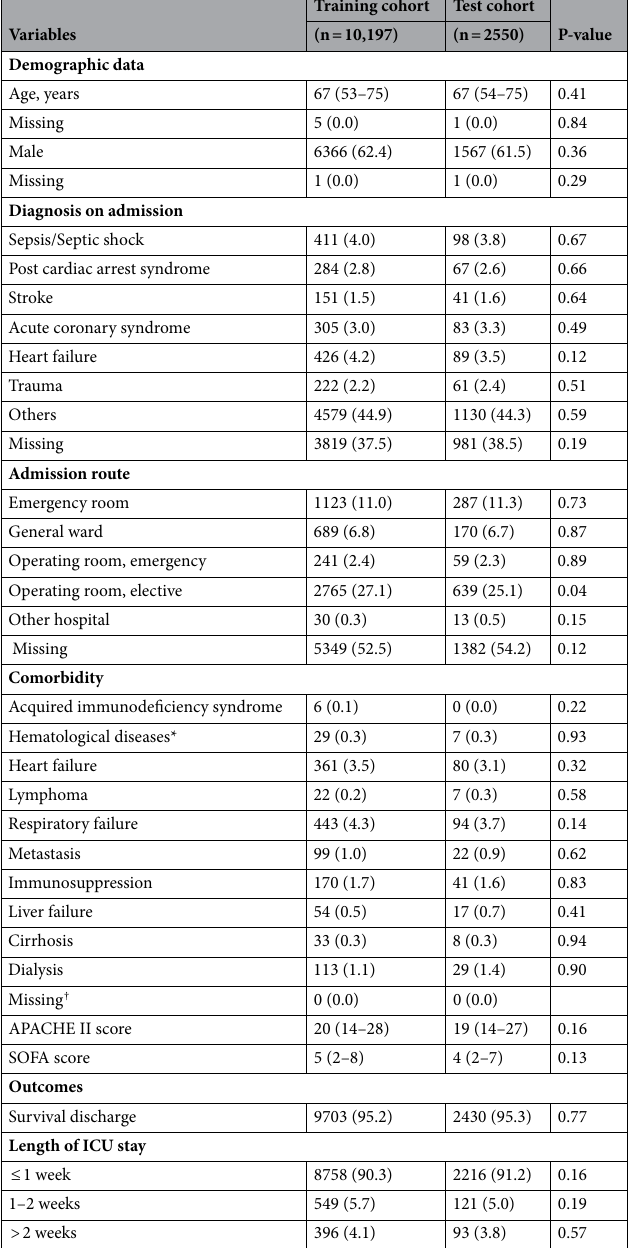
Table 1. Baseline characteristics and outcomes of patients in the training and test cohorts. Data are expressed as median (interquartile range) for continuous variables and as exact numbers (%) for categorical variables. APACHE acute physiology and chronic health evaluation, SOFA sequential organ failure assessment, ICU intensive care unit. P-values were calculated using Pearson’s chi-square test and Mann–Whitney U test. *Hematological diseases include acute myeloid leukemia and multiple myeloma. † Comorbidities were treated as not having if their data were